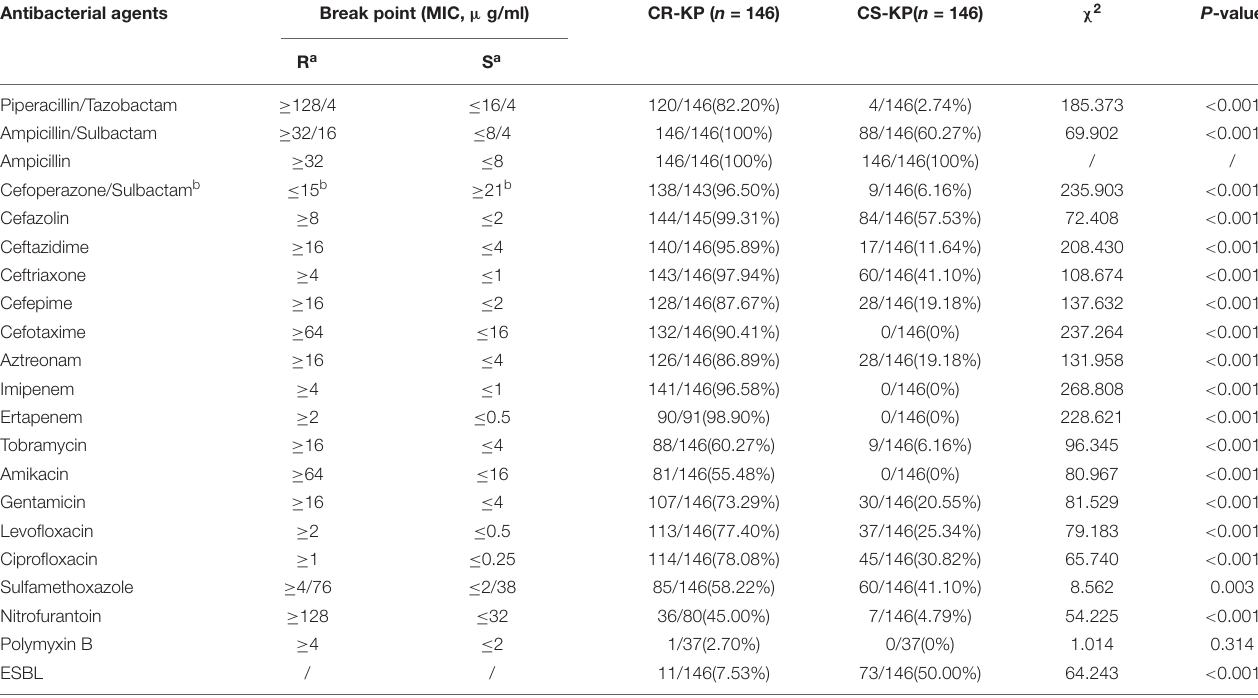
TABLE 2 | The differences in antibacterial profiles between carbapenem-resistant Klebsiella pneumoniae (CR-KP) and carbapenem-susceptible K. pneumoniae (CS-KP). Antibacterial agents Break point (MIC, µ g/ml)